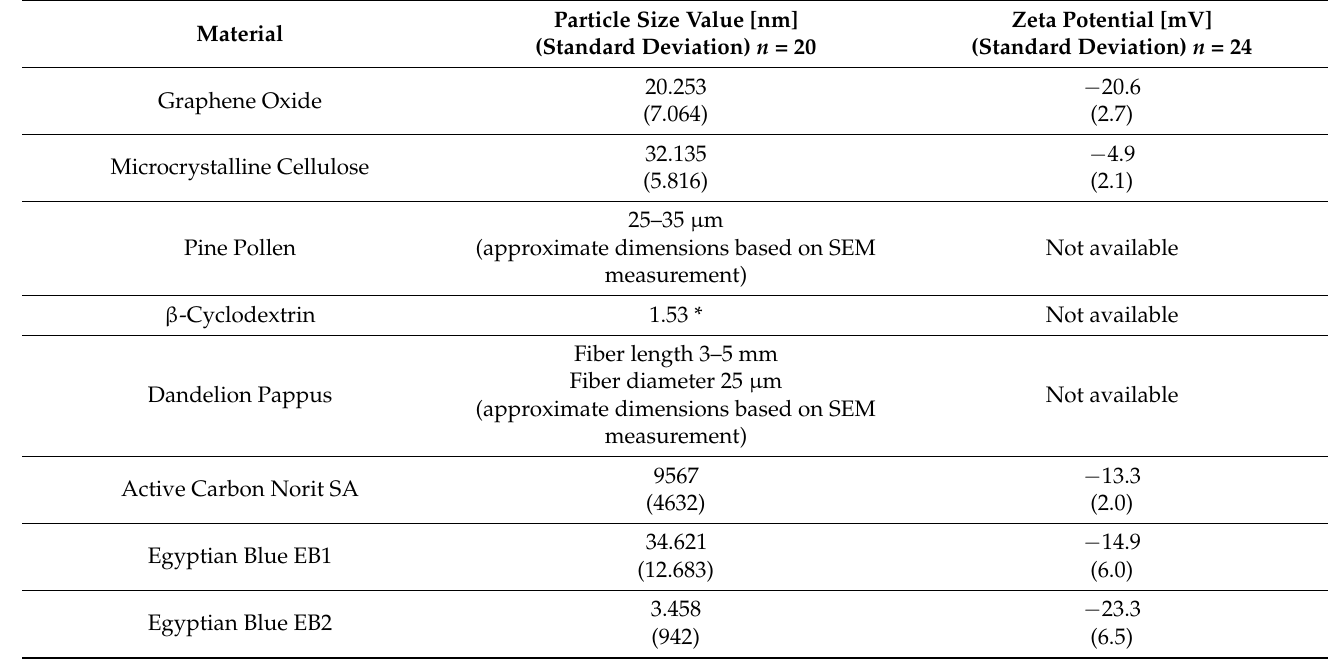
Table 1. Measured values of particles size and zeta potential for additives studied. Raw materials were suspended in distilled water at concentration of 0.2 mg/mL, followed by 60 min of